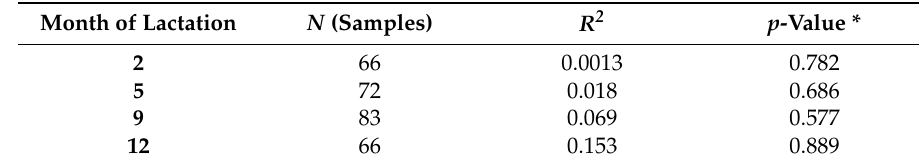
Figure 4. ( a ) Association between skim and whole human milk (HM) leptin ( n = 287). No association was detected between skim and whole HM leptin levels in matched samples ( R 2 = 0.001, p = 0.552); ( b ) no association was detected between fat content and leptin concentration in whole HM ( R 2 = 0.0004, p = 0.17, n = 284). The solid black line is the line of best fit. Table 4. Association between leptin levels in whole human milk and fat content at each stage of